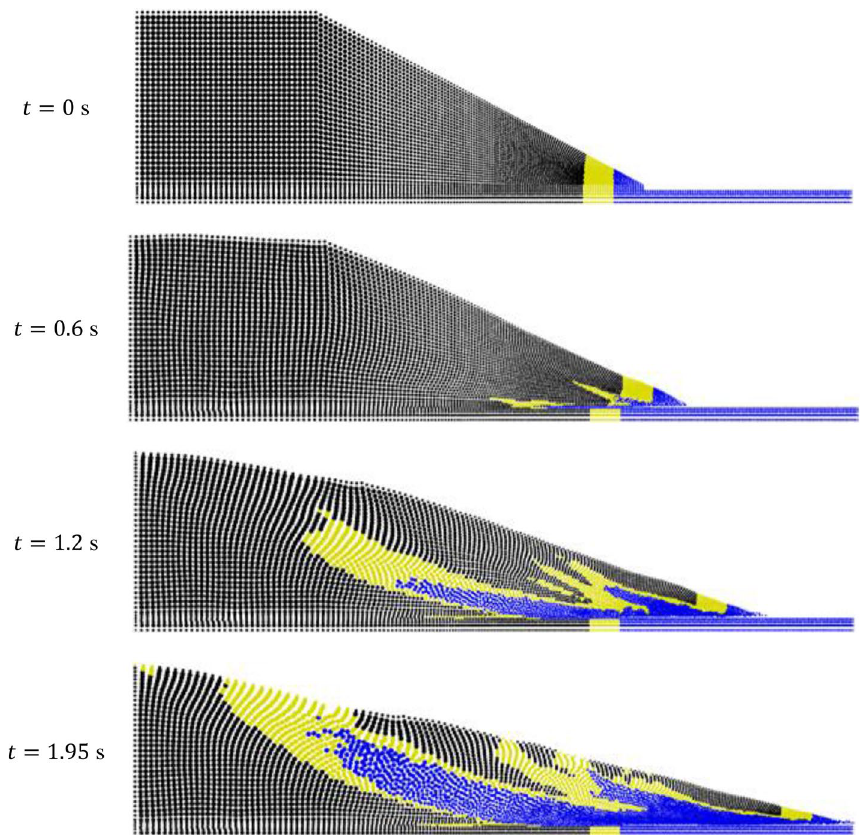
Fig. 20 Progressive levee failure for the coupled L–SL RK simulation plotting Lagrangian (black nodes), semi‑Lagrangian (blue nodes), and transition (yellow nodes)